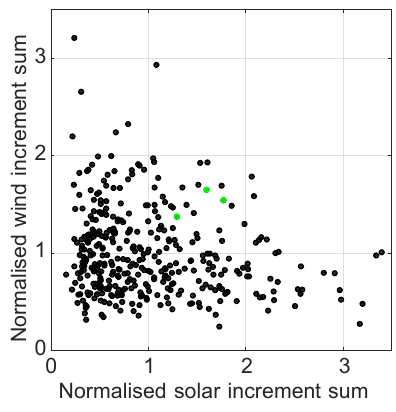
Figure 8. Daily spatial wind and solar variability for all days in the year 2009. The days with cellular convection are marked in